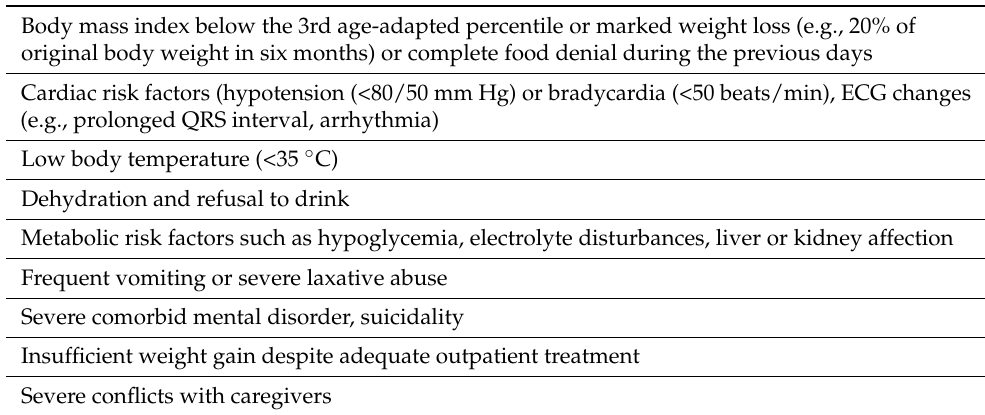
Table 1. Indications for admission to hospital for adolescents with anorexia nervosa (AN)